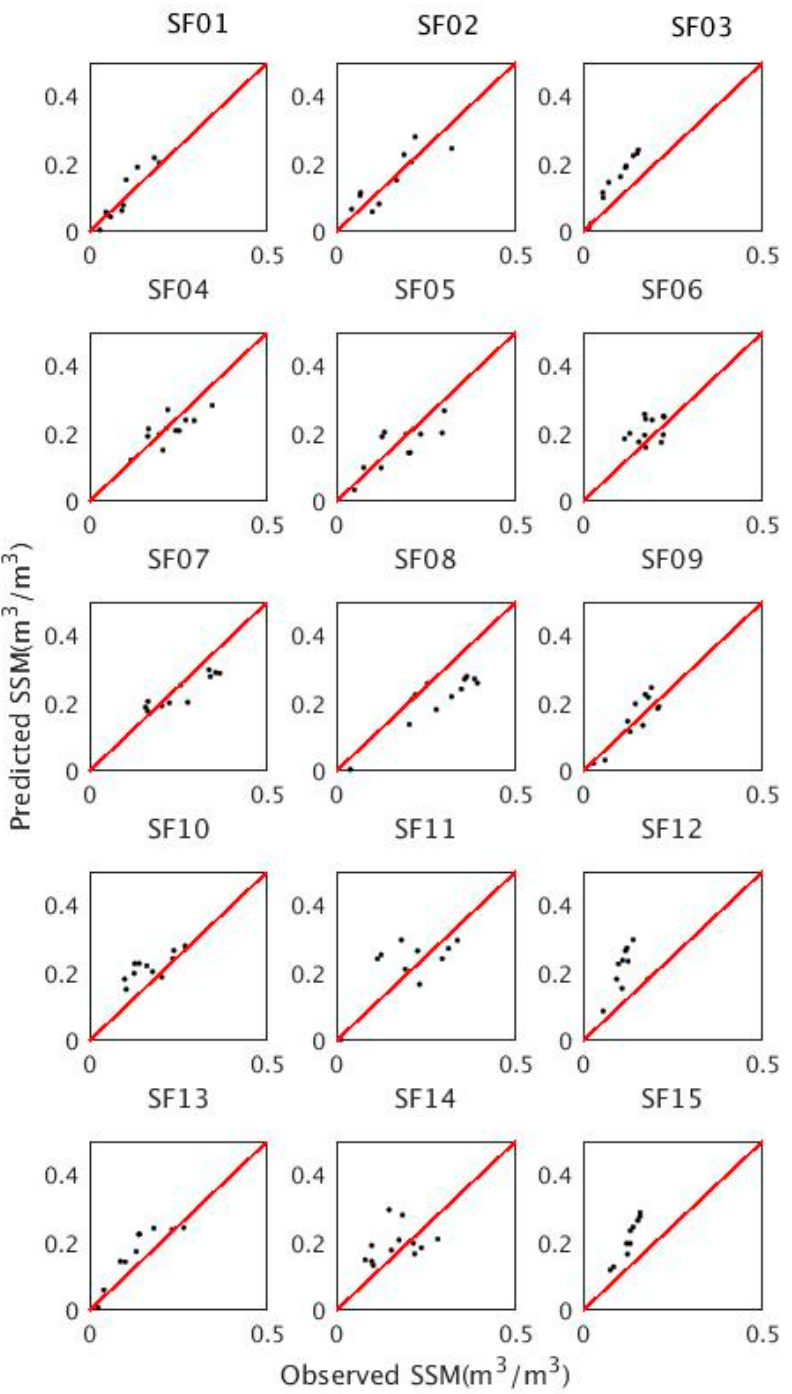
Figure 7. Results of the predicted SSM with the observed SSM.